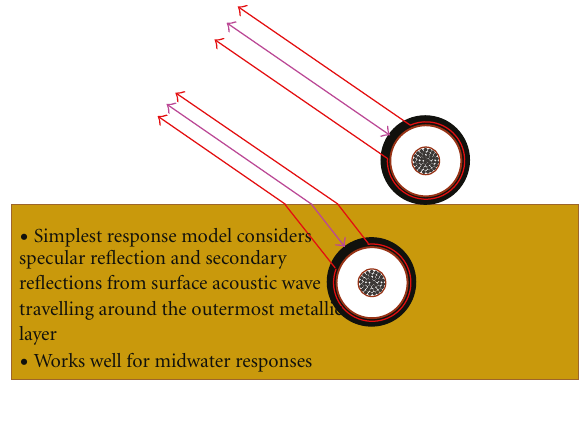
Figure 27: Major contributions to echo structure come from the specular return and the surface waves travelling in the outer copper conducting layer. The relative path lengths are a ff ected by refraction at the water/sediment